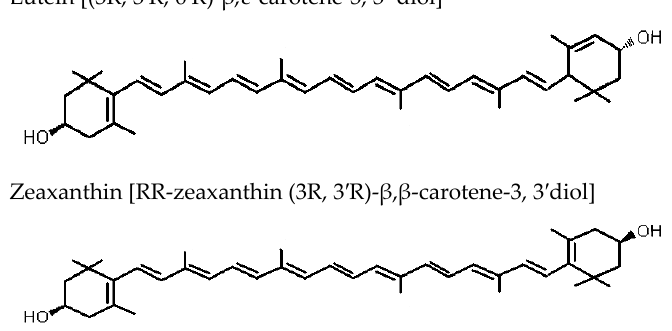
Figure 2. Biochemical structures of the carotenoids lutein and zeaxanthin.